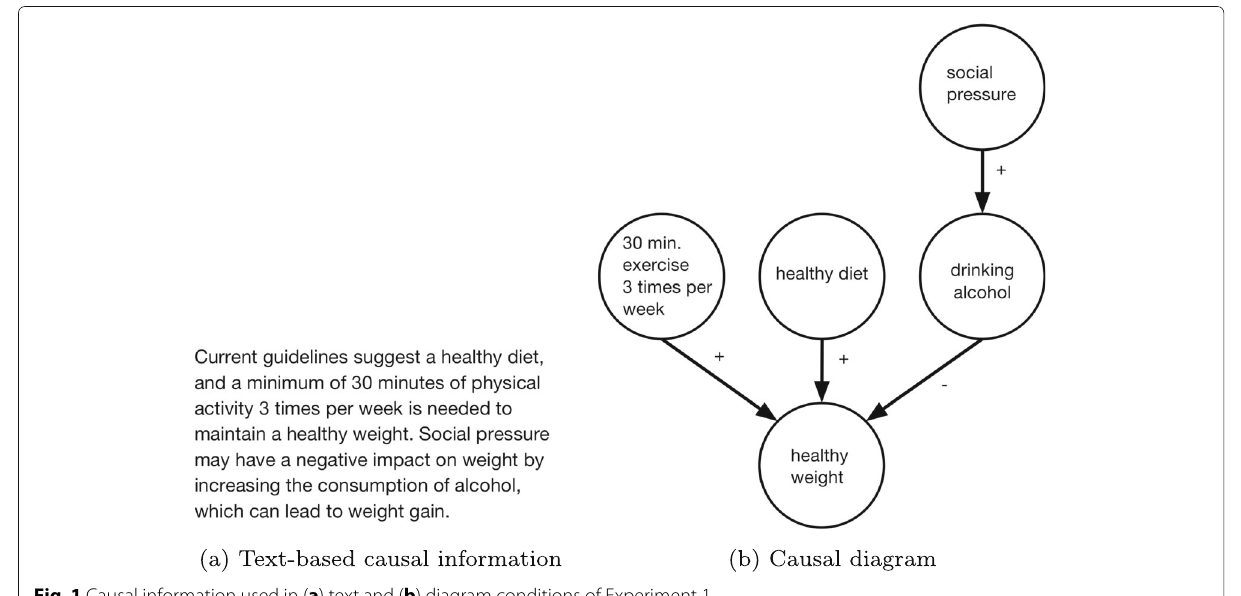
Fig. 1 Causal information used in ( a ) text and ( b ) diagram conditions of Experiment 1